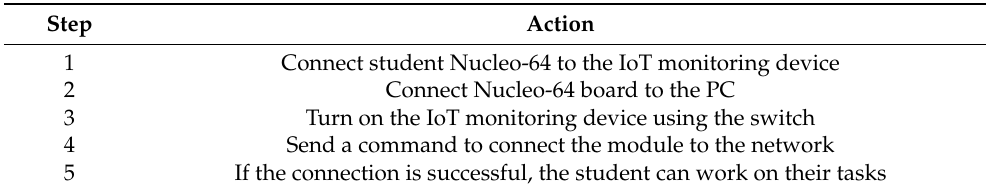
Table 2. Procedure for using the IoT monitoring device—student’s